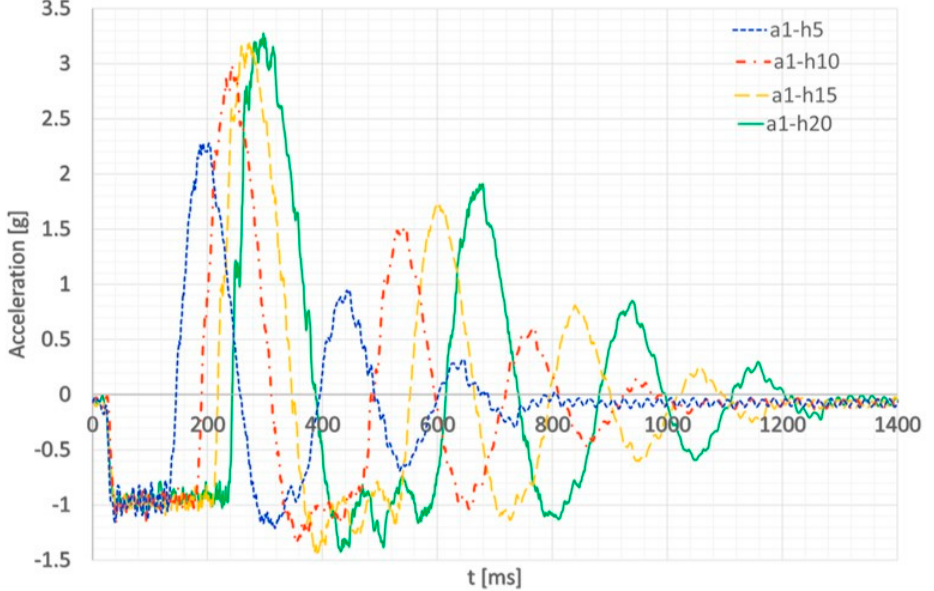
Figure 17. Example of accelerometer signals’ superposition at four different heights (accelerometer a1). ( a1-h5 ) h = 0.05 m; ( a1-h10 ) h = 0.10 m; ( a1-h15 ) h = 0.15 m; and ( a1-h20 ) h = 0.20